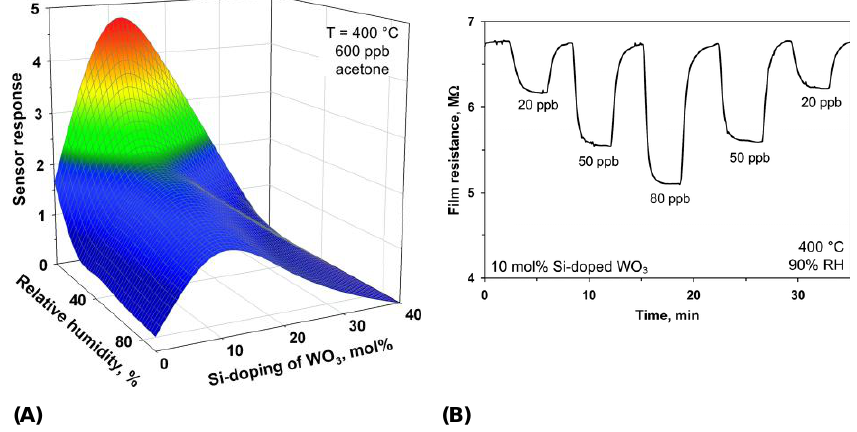
Figure 2. ( A ) The response of WO 3 -based sensors at 400 °C to 600 ppb of acetone are depicted with respect to Si-content and relative background humidity. A sensor based on 10% mol Si-doped WO3 is optimal. ( B ) Using this sensor it was possible to detect ultralow concentrations of acetone (20–90 ppb) in 90% RH [16]. The figure is reprinted from [16]. Copyright 2010 American Chemical Society. Table 5. A list of different samples used to detect acetone.